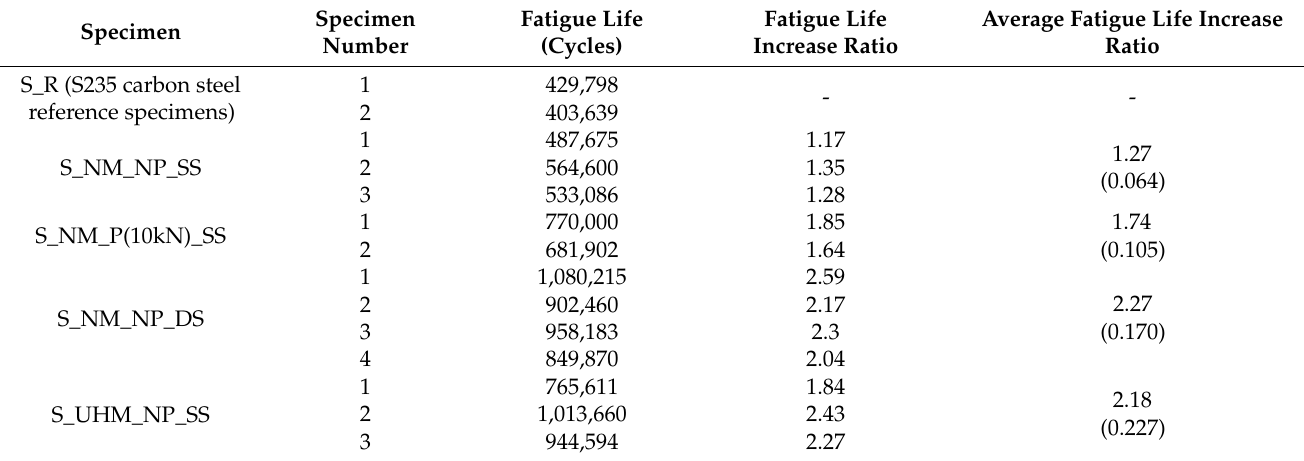
Table 2. Experimental results for reinforced S235 carbon steel specimens.